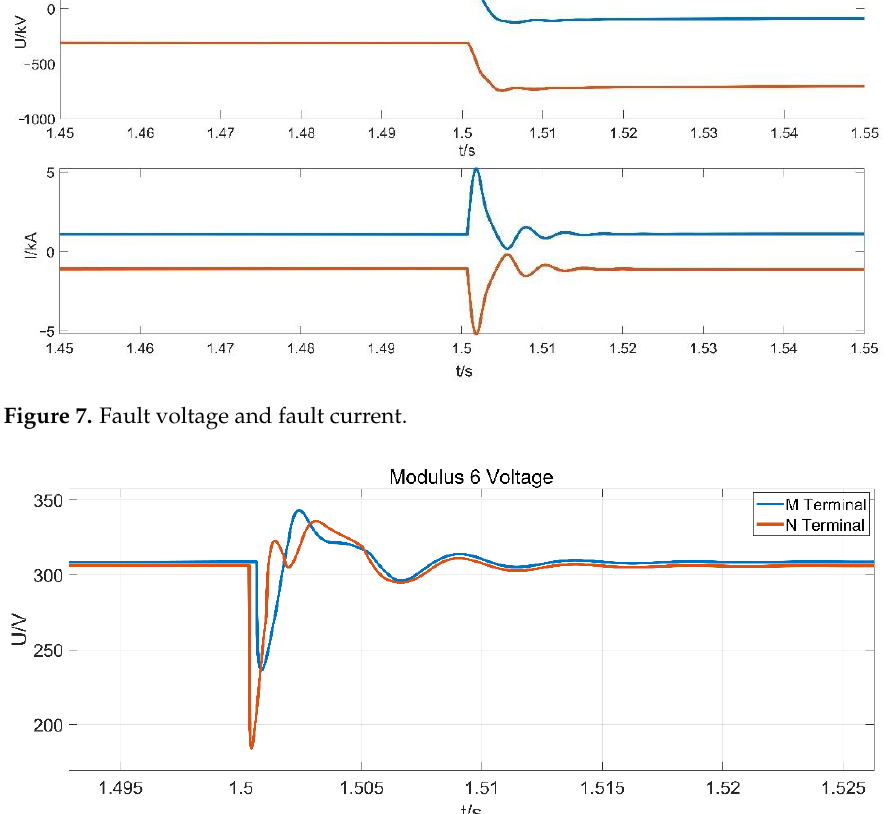
Figure 8. Six-mode voltage fault waveform.